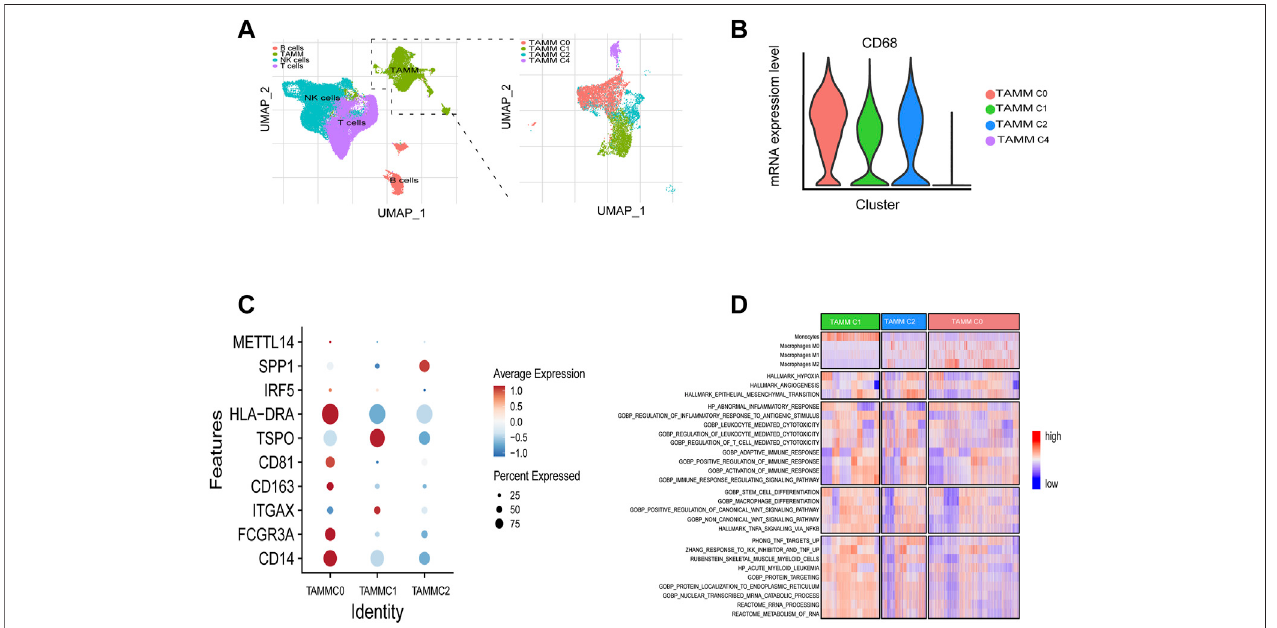
FIGURE 1 | Cellular heterogeneity of tumor-associated monocyte/macrophages/macrophages at the single cell level. (A) Umap plots of all clusters annotated by SingleR. (B) CD68 expressions levels of TAMM sub-clusters (C0, C1, C2, C4). (C) CD14, CD16, ITGAX, CD201, CD81, TSPO, HLA-DRA, IRF5, SPP1, and METT14 expressions levels of TAMM sub-clusters (C0, C1, C2). (D) GSVA revealed the enrichment scores of TAMM sub-clusters in the pathways of tumor invasion, immunity, stemness, and